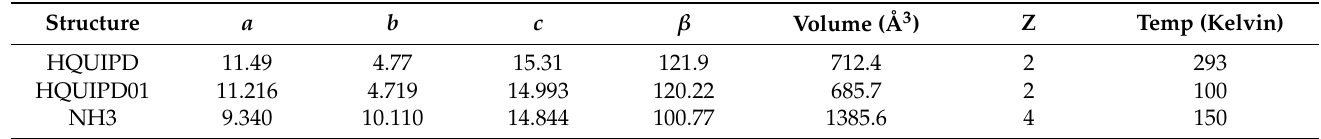
Figure 1. ( a ) Schematic for the structure of the synthesized complex NH3; ( b ) Flow diagram for the synthesis of the compound NH3. Table 1. Comparison of crystallographic unit cell constants in P2 1